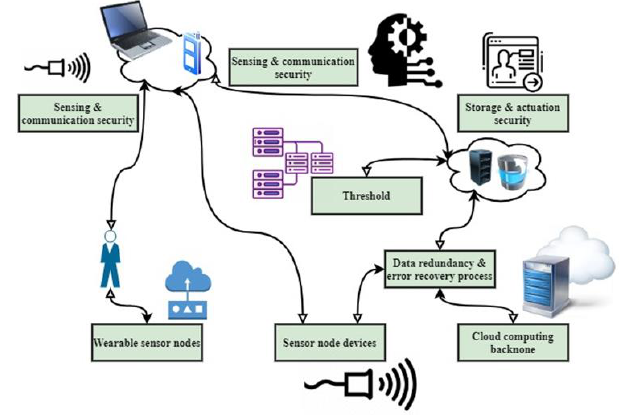
Figure 2. The workflow of the proposed IWMCPS model.